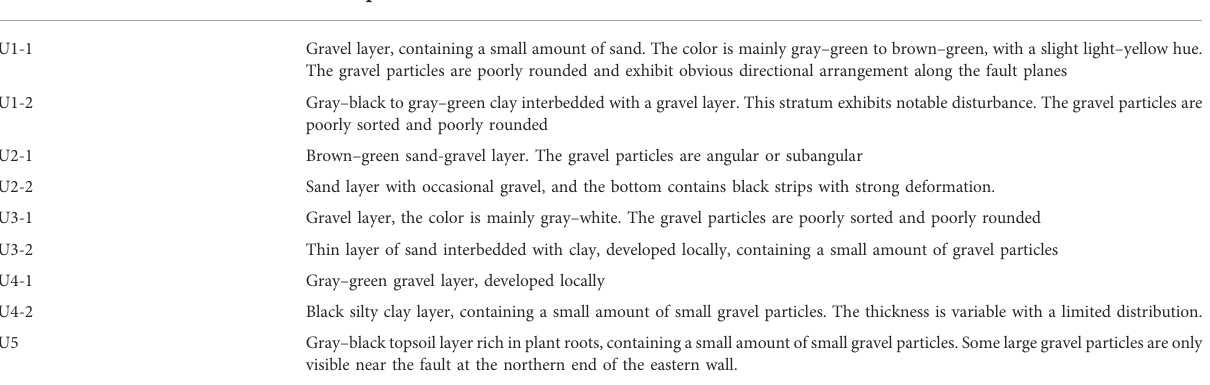
TABLE 2 Unit description of trench